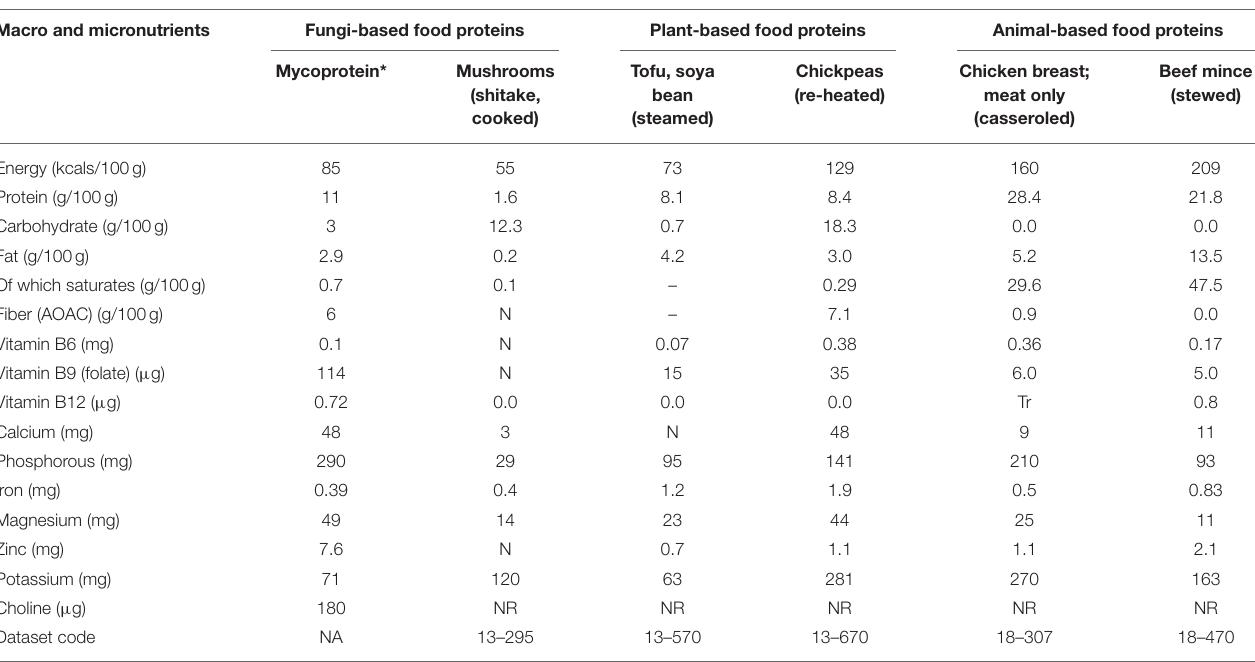
TABLE 1 | The nutritional profile of various protein sources. Macro and micronutrients Fungi-based food proteins Plant-based food